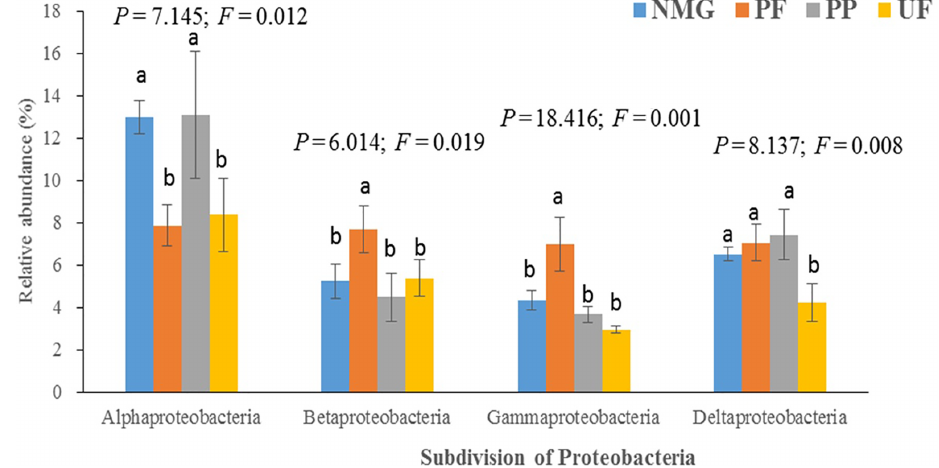
Figure 3. Subdivision distribution of Proteobacteria phylum. NMG: native meadow grassland; UF: 50-year upland field; PF: 26-year paddy field; PP: 34-year poplar plantation. Table 3. Results of one-way ANOVA for the relative abundance of phyla and genera in different land-use types.